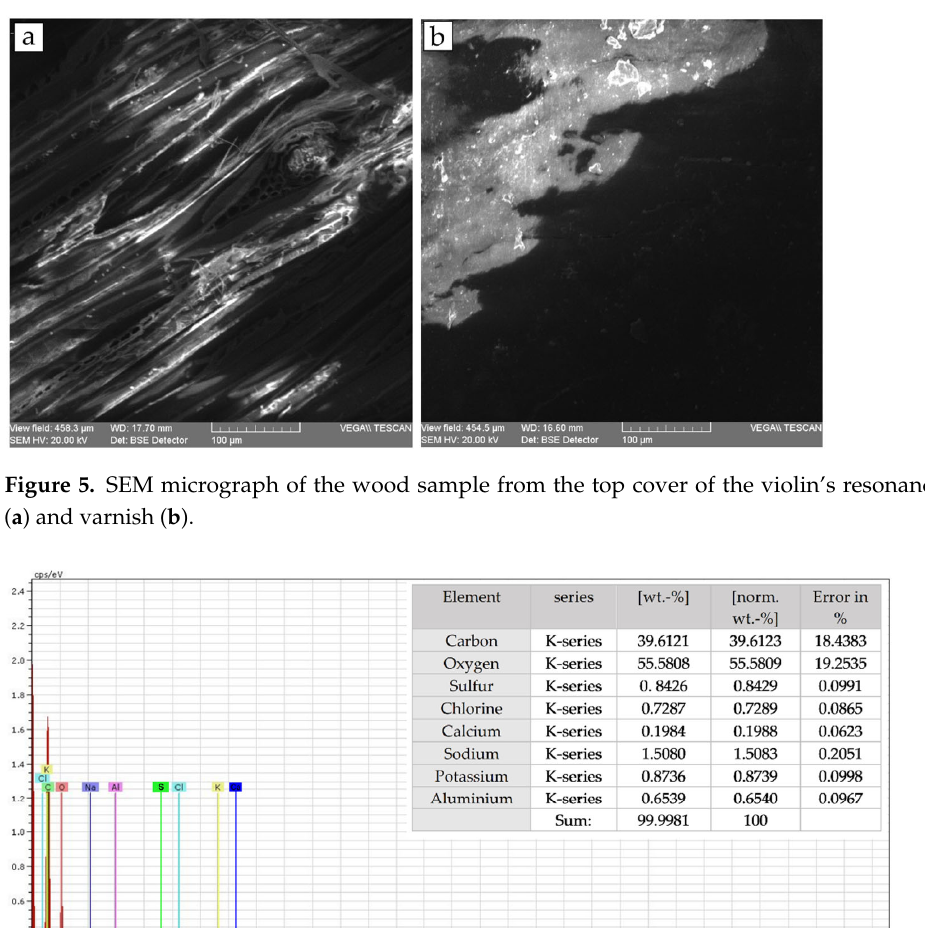
Appl. Sci. 2023 , 13 , x FOR PEER REVIEW Figure 6. EDX spectrum for the spruce wood sample. Figure 6. EDX spectrum for the spruce wood sample.